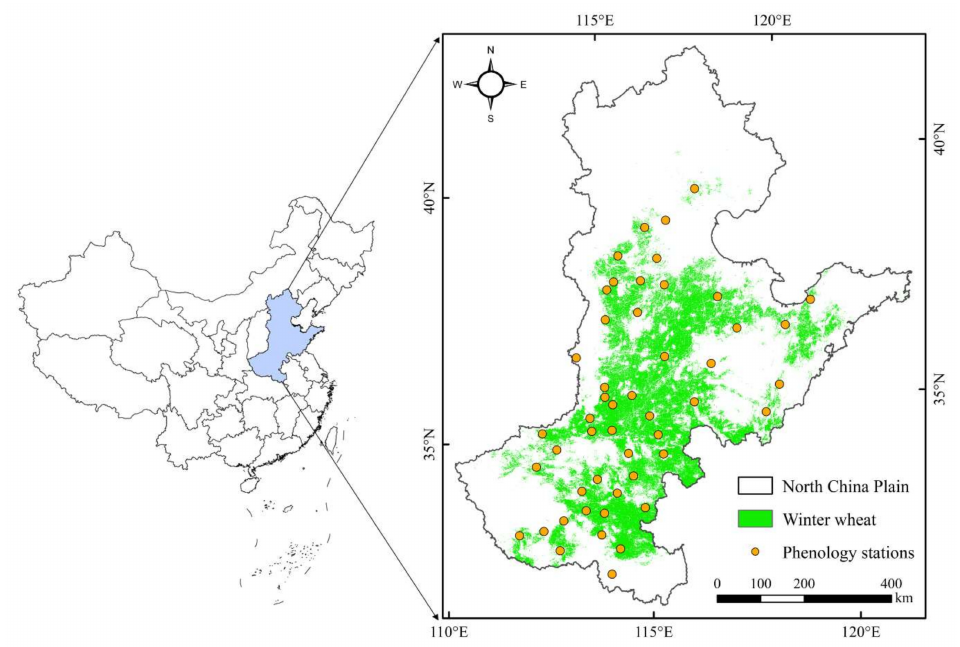
Figure 1. Location of the study area and phenology observation stations for winter